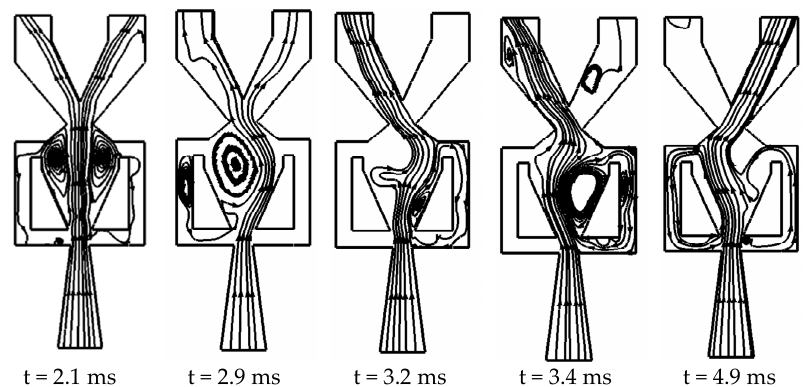
Figure 12. Distribution of streamlines at different times in model M 7, 10.